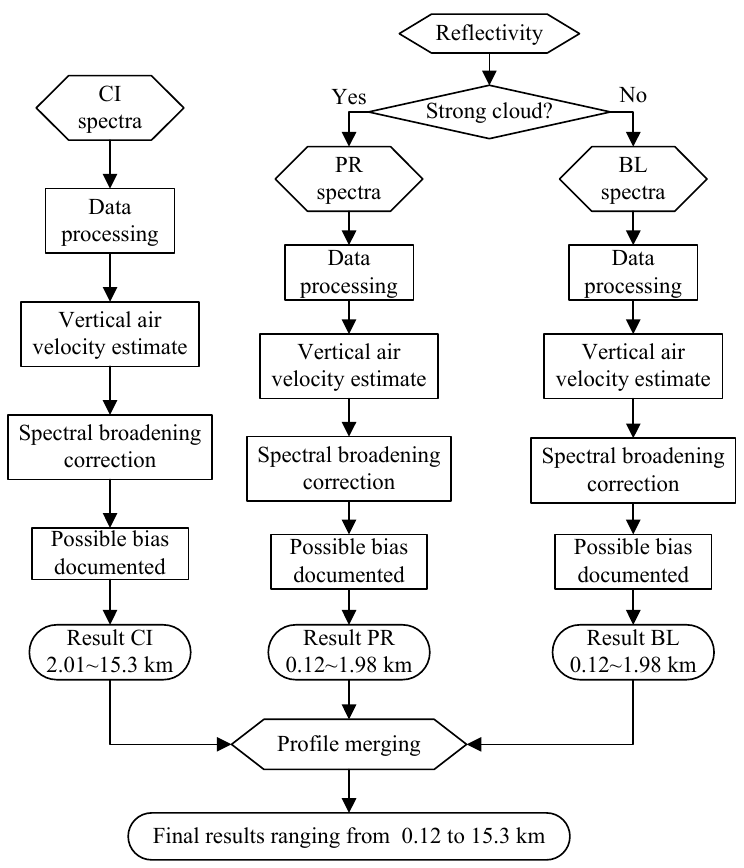
Figure 5. Flow diagram of the integrated technique for retrieval of vertical air velocity using multimode Doppler spectra.